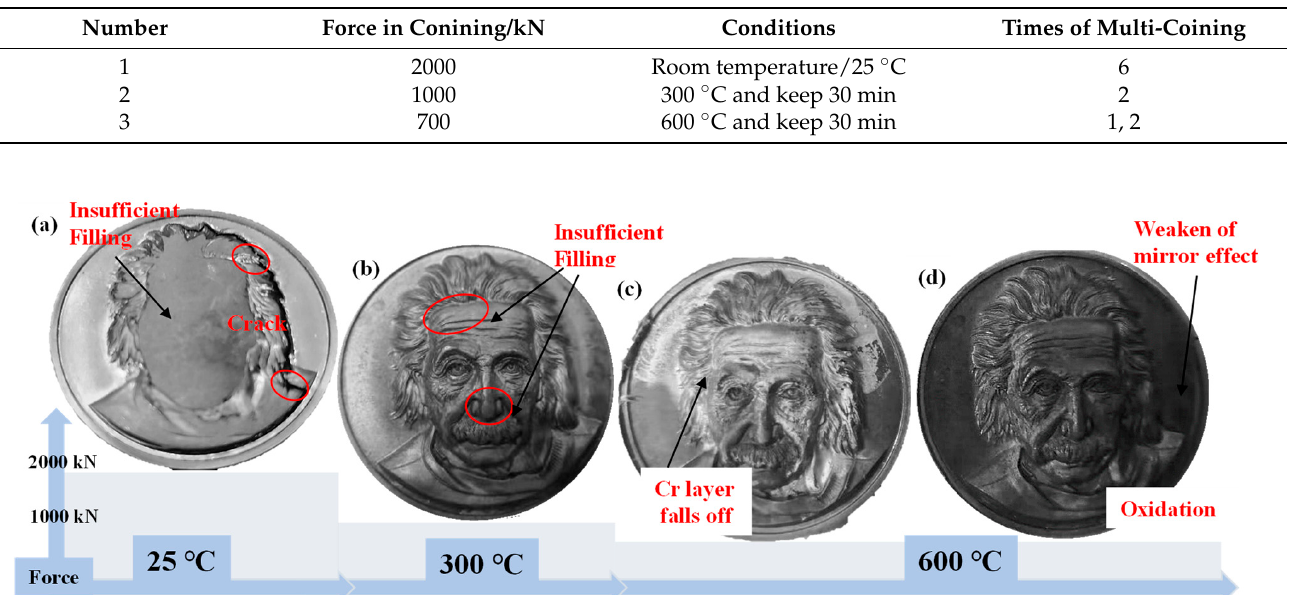
Table 1. The process parameters of the closed multi-coining process.